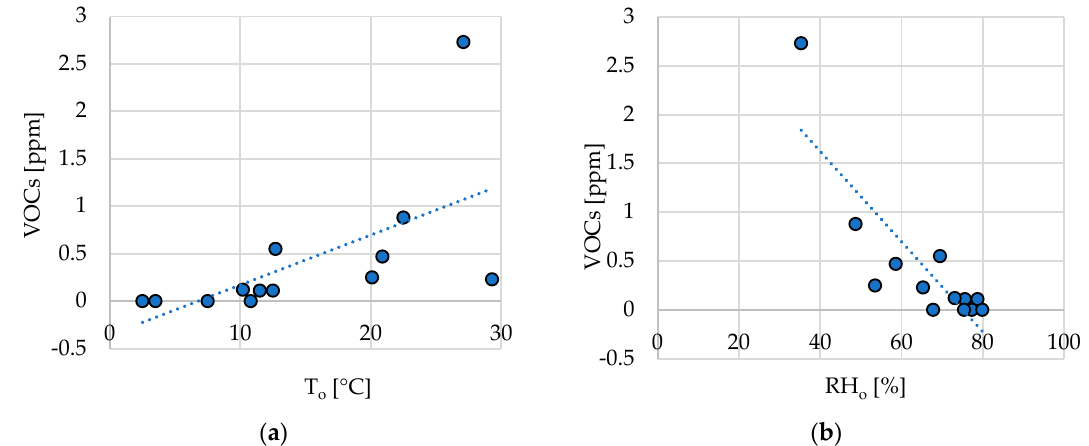
Figure 12. Correlation diagrams between VOC concentration in front of the mechanical treatment hall entrance at biogas plant A and measured microclimatic parameters, with regression lines: ( a ) R 2 = 0.37, ( b ) R 2 = 0.70.